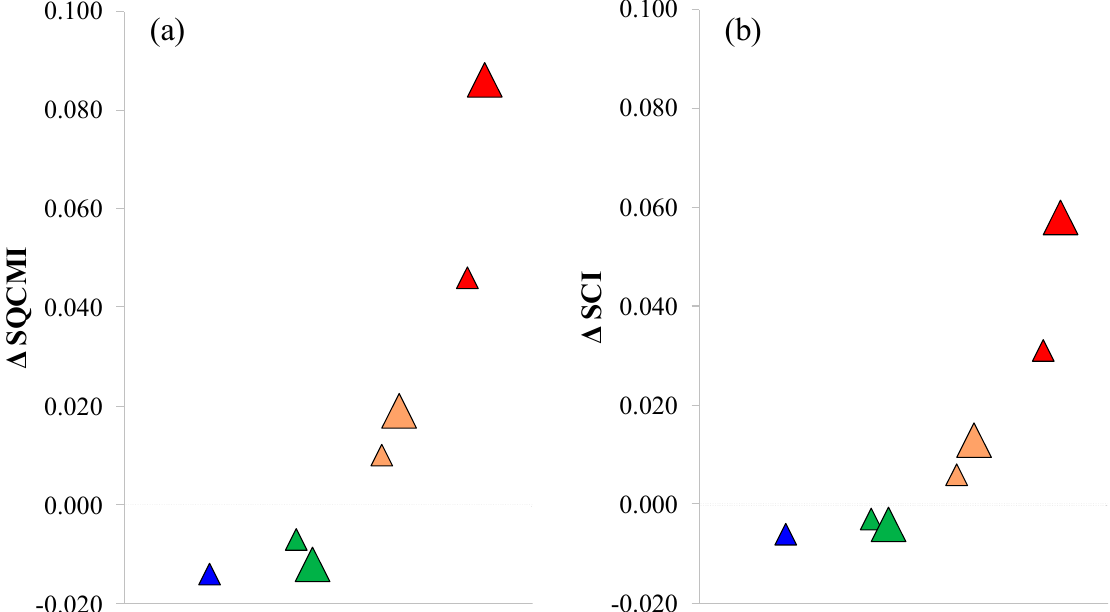
Figure 5. Δ SQCMI ( a ) and Δ SCI ( b ) values resulting from the dispersion of 50 g m -2 (small triangles) and 100 g m -2 (big triangles) of dust_1 (blue), dust_2 (green), dust_3 (orange) and dune sand (red) on the surface of 1/loess soil; x -axis offset for clarity.